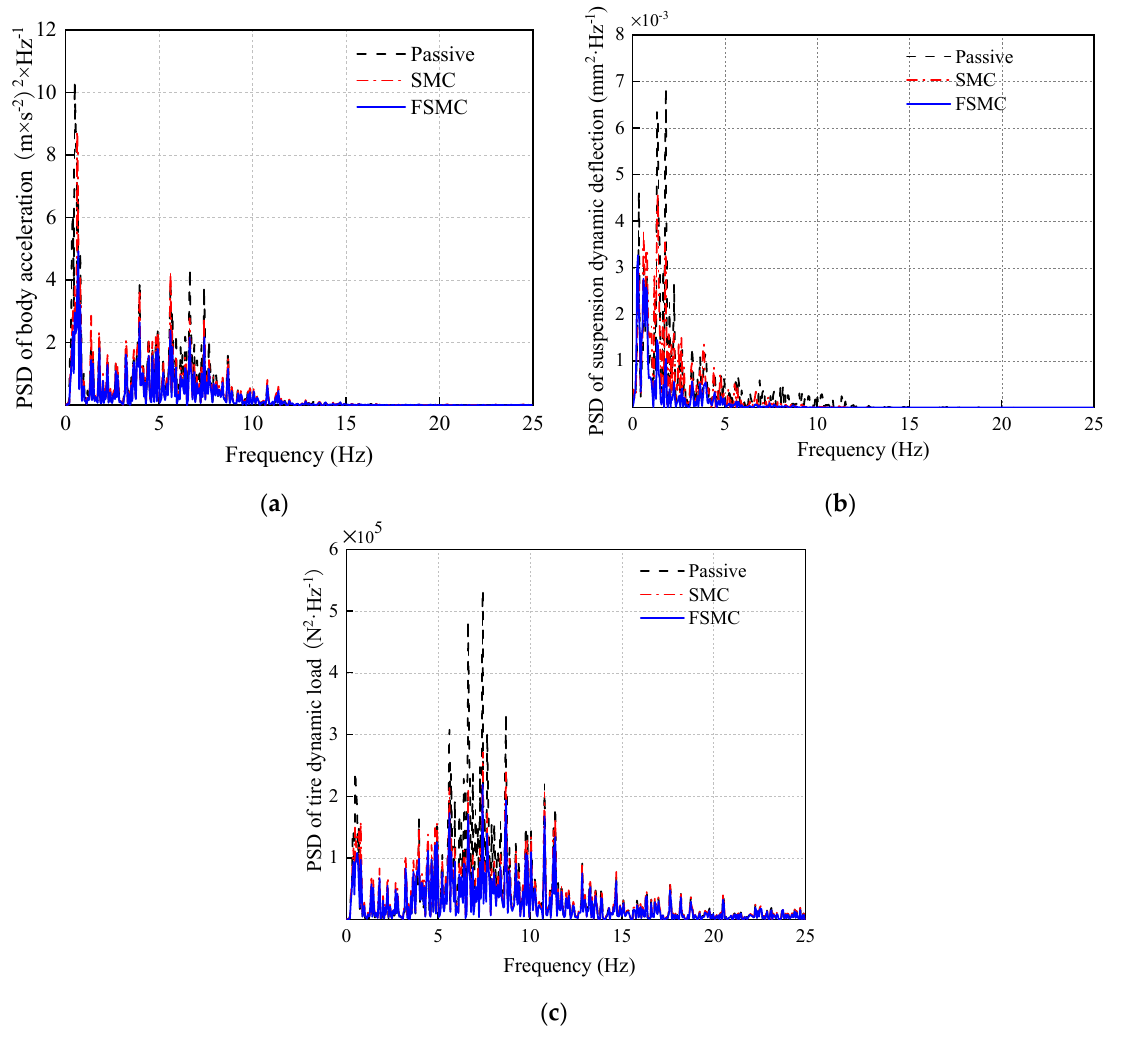
Figure 18. Simulation curve of power spectral density of air suspension system under random road excitation. ( a ) Body acceleration, ( b ) suspension dynamic deflection, ( c ) tire dynamic load.